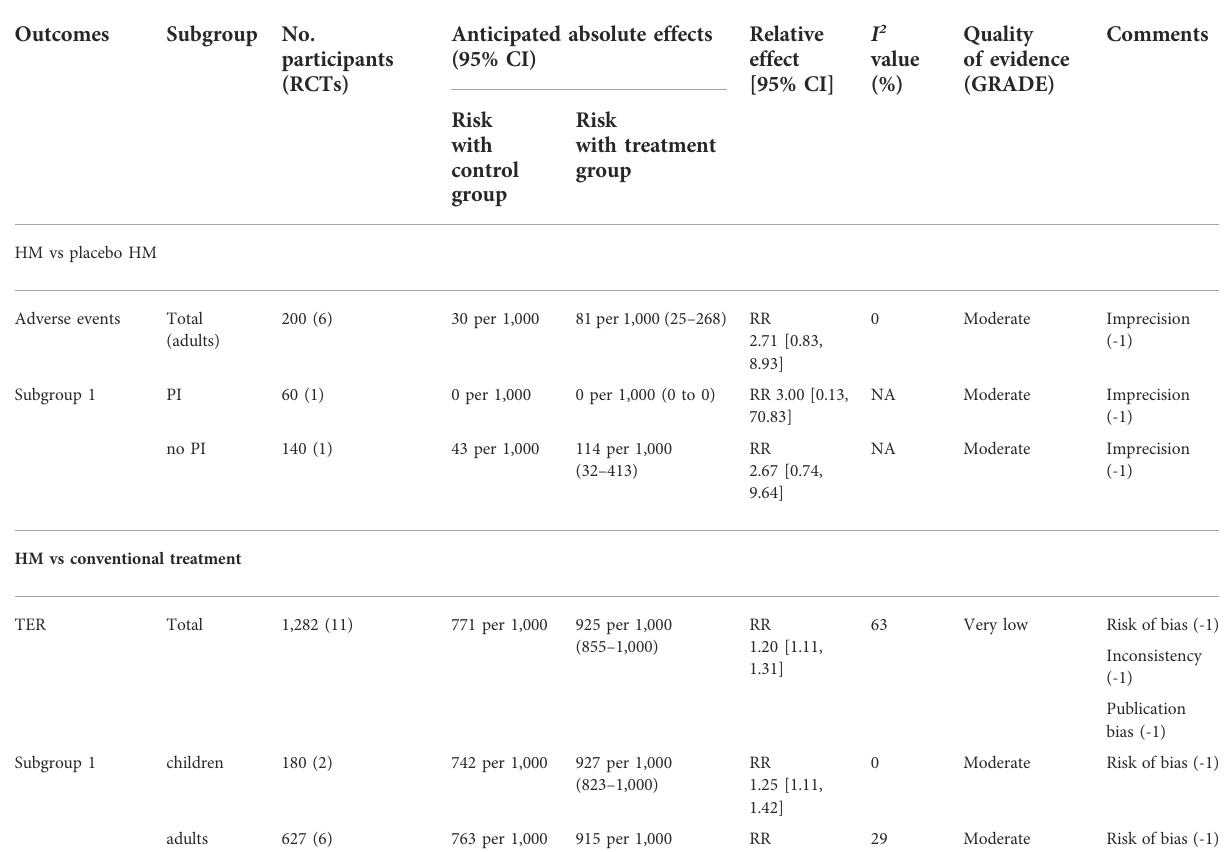
TABLE 1 Summary of fi